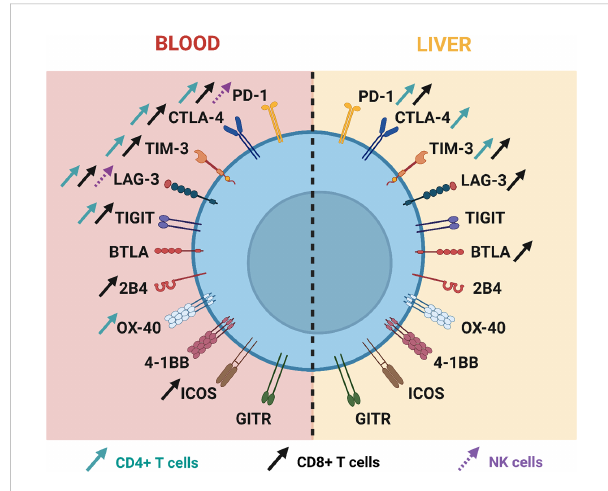
FIGURE 2 Current knowledge about immune checkpoint expression on T cells and NK cells during chronic HBV